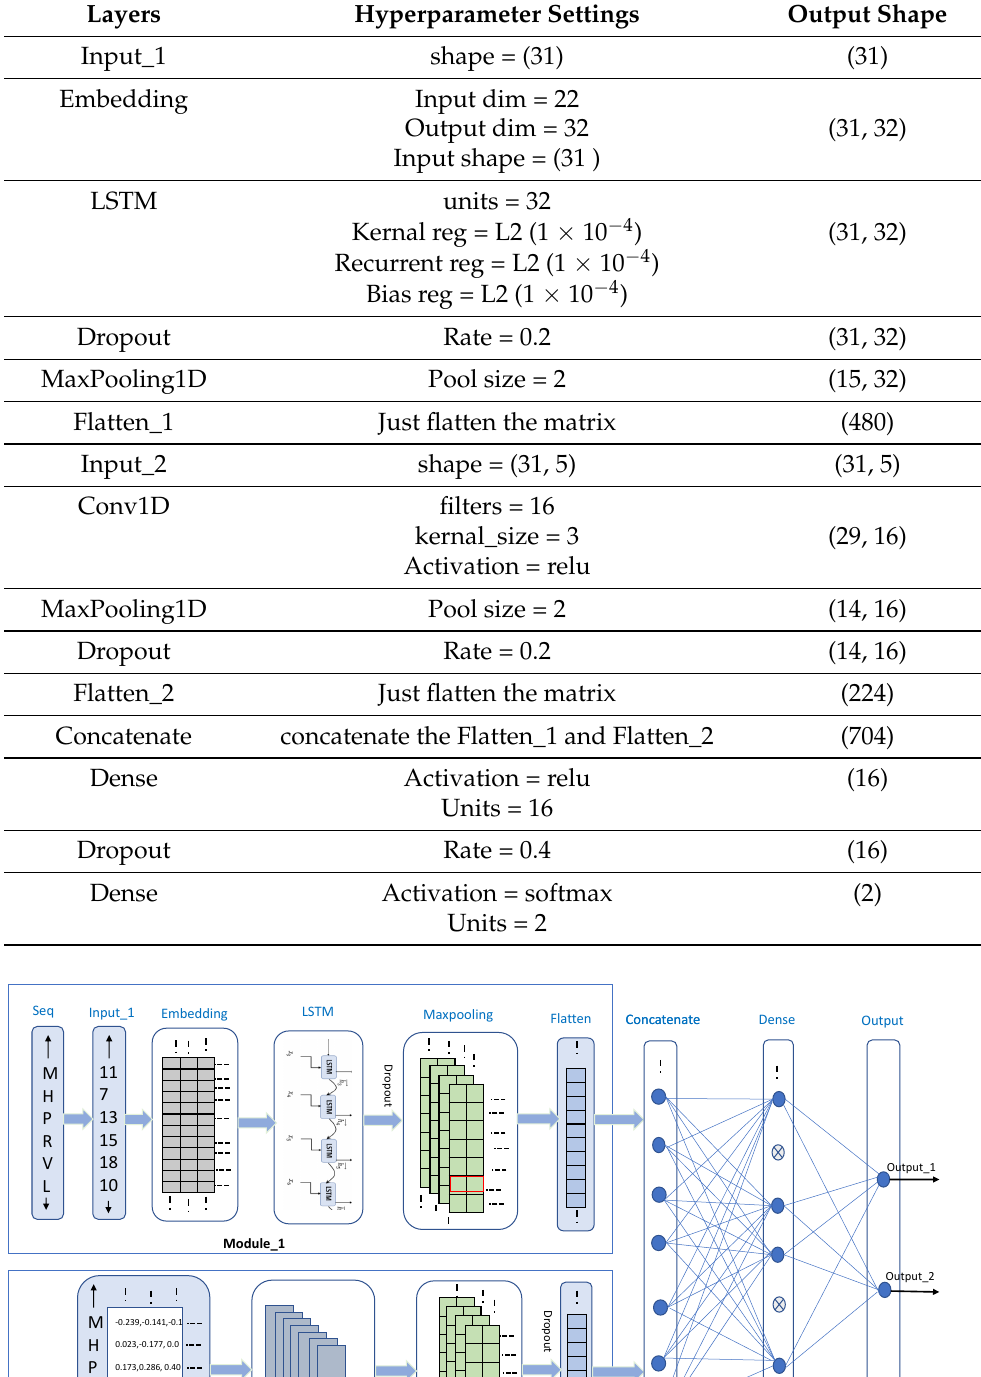
Table 1. Proposed Model Layer Hyperparameter Details.